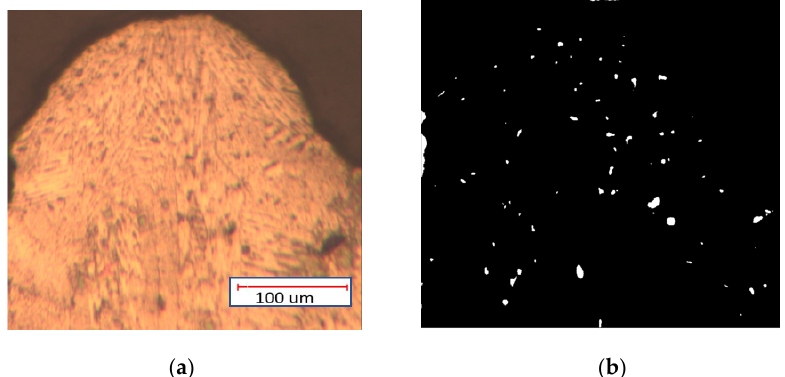
Figure 2. ( a ) Bead cross section, ( b ) identification of porosities across the bead cross section using a color